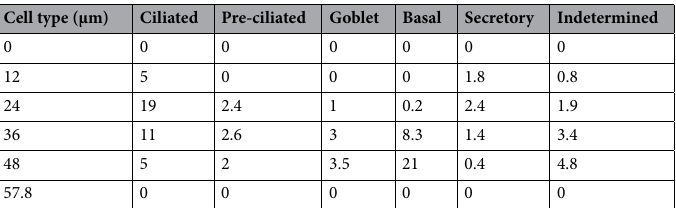
Figure 3. Dimensions of ( a ) the bronchial epithelium section for the simulation of alpha-particle emissions from radon progeny within the mucous layer and ( b ) six cell types constituting the epithelium section. Cell type (μm) Ciliated Pre-ciliated Goblet Basal Secretory